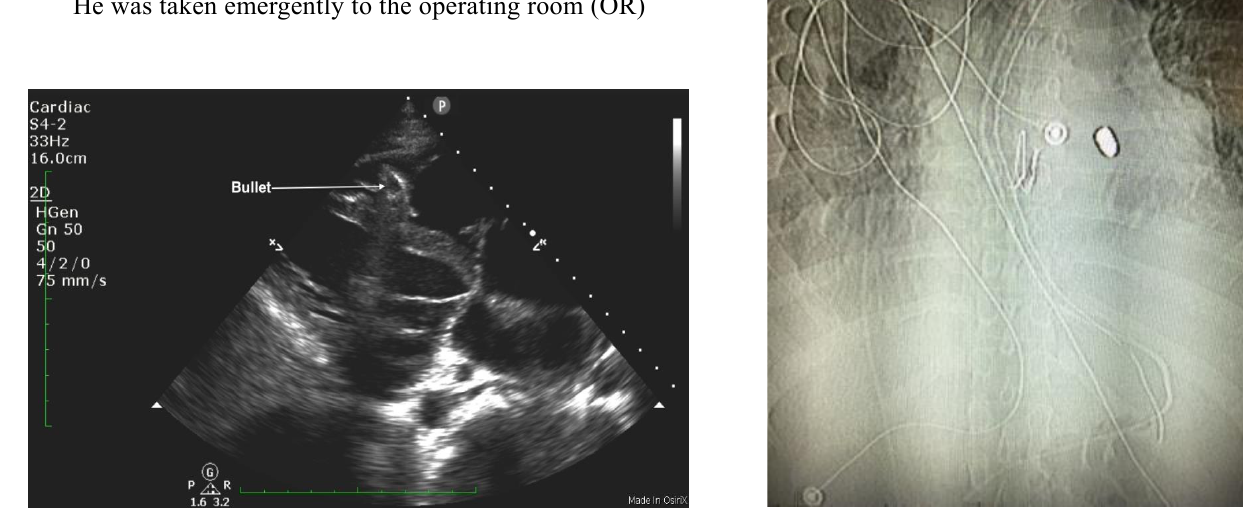
Figure 2. Anteroposteior chest x-ray demonstrating bullet fragment overlying the cardiac